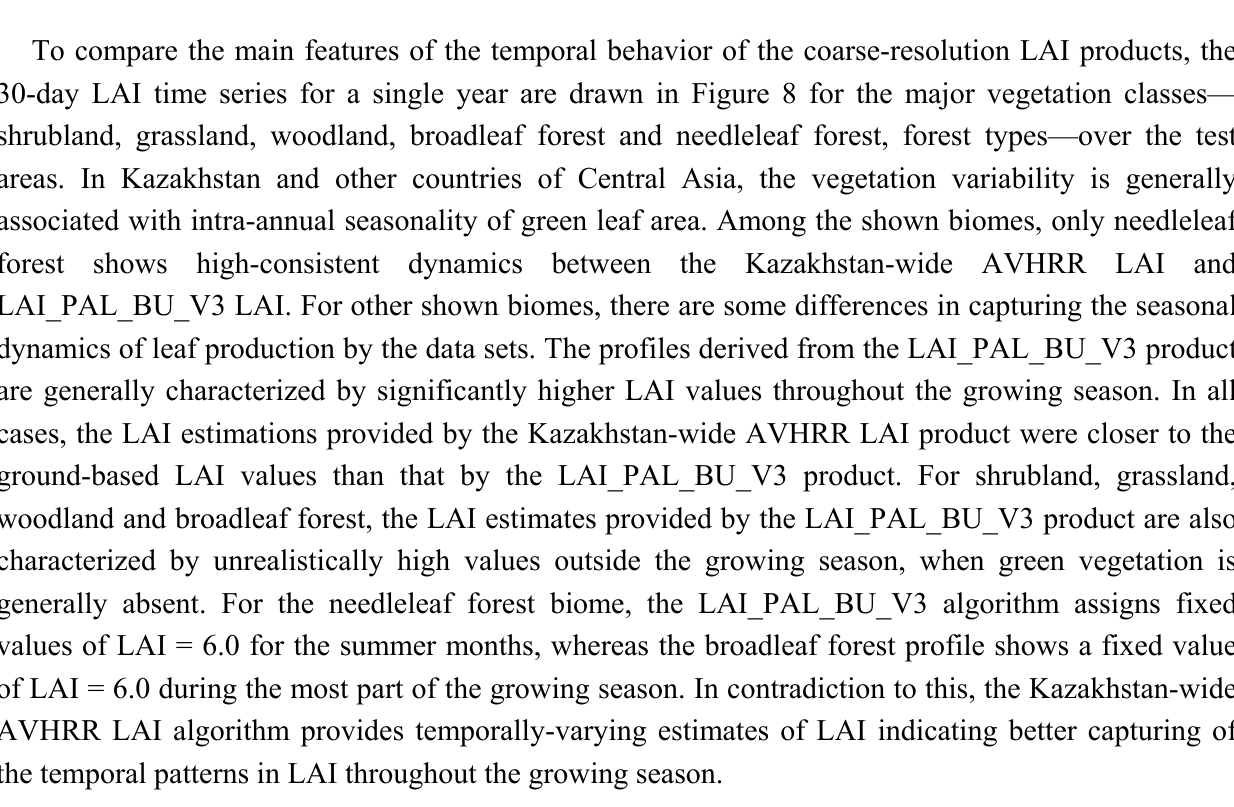
Figure 8. Temporal profiles of LAI estimates from the LAI_PAL_BU_V3 product, the Kazakhstan-wide AVHRR LAI product and ground-based measurements at test